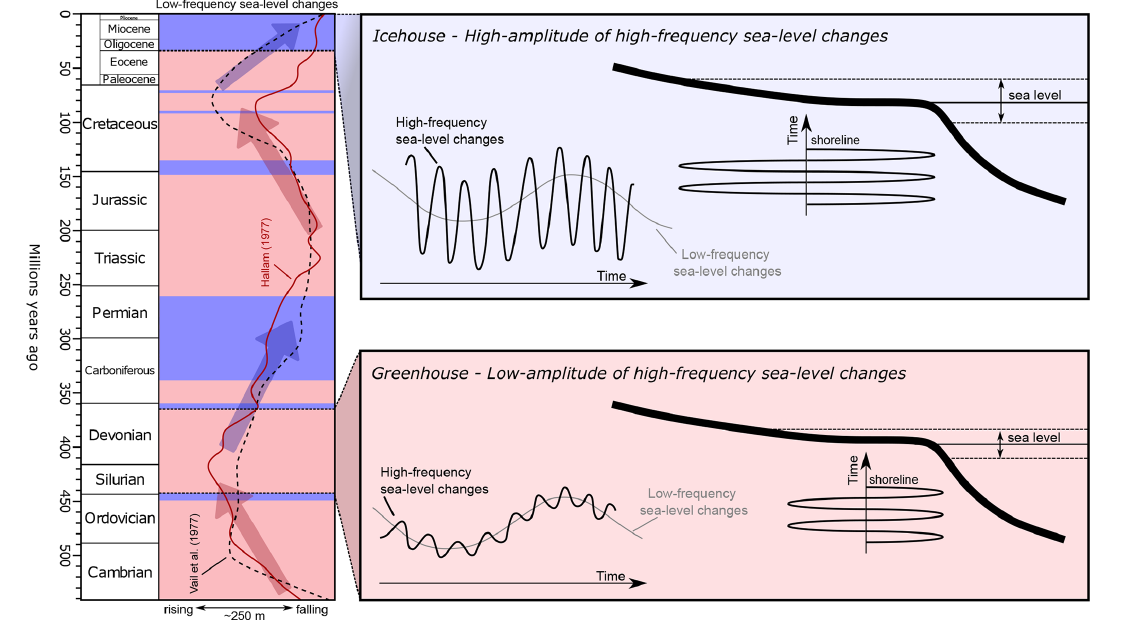
Figure 5. Changing frequencies and amplitudes of eustasy. Sea-level curves, according to Vail et al. (1977) and Hallam (1977). In icehouse periods (in blue), these cycles have a high amplitude, mainly due to the effects of glacioeustasy. Eustatic oscillations have lower amplitude in greenhouse periods (in light red) since there is no significant glacial effect (modified from Wilson, 1998; Séranne, 1999; Montañez et al.,